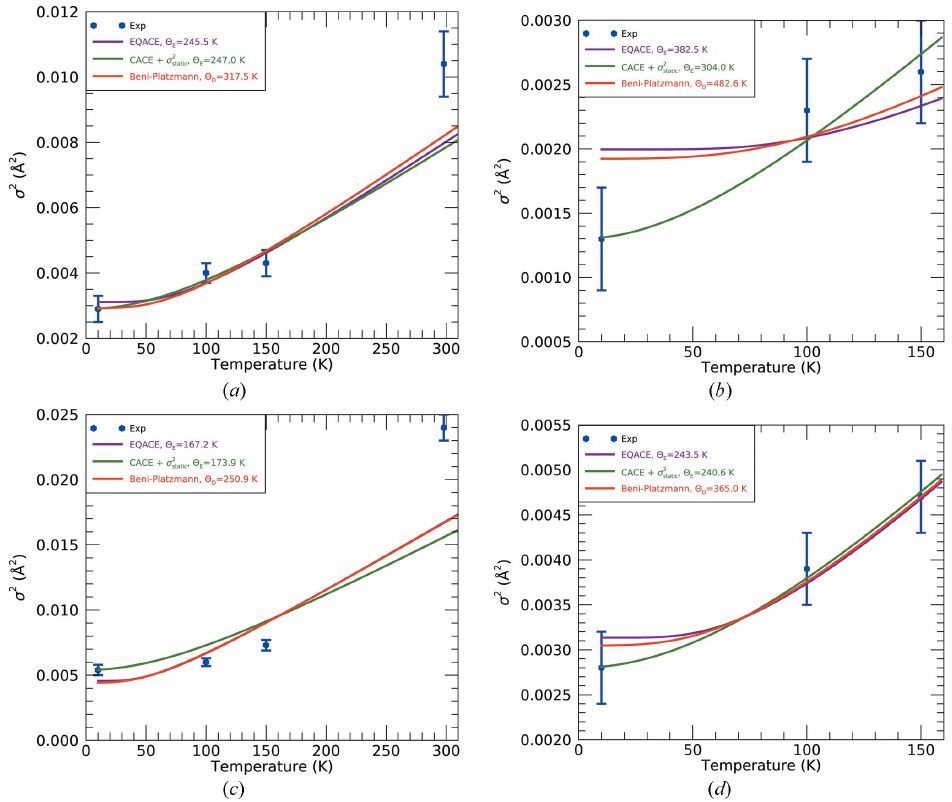
Figure 24 Comparisons of ( a , b ) first-shell and ( c , d ) third-shell Debye–Waller factors between experimental results for the EQACE, CACE and Beni–Platzmann (correlated Debye) models for the ( a , c ) transmission and ( b , d ) fluorescence